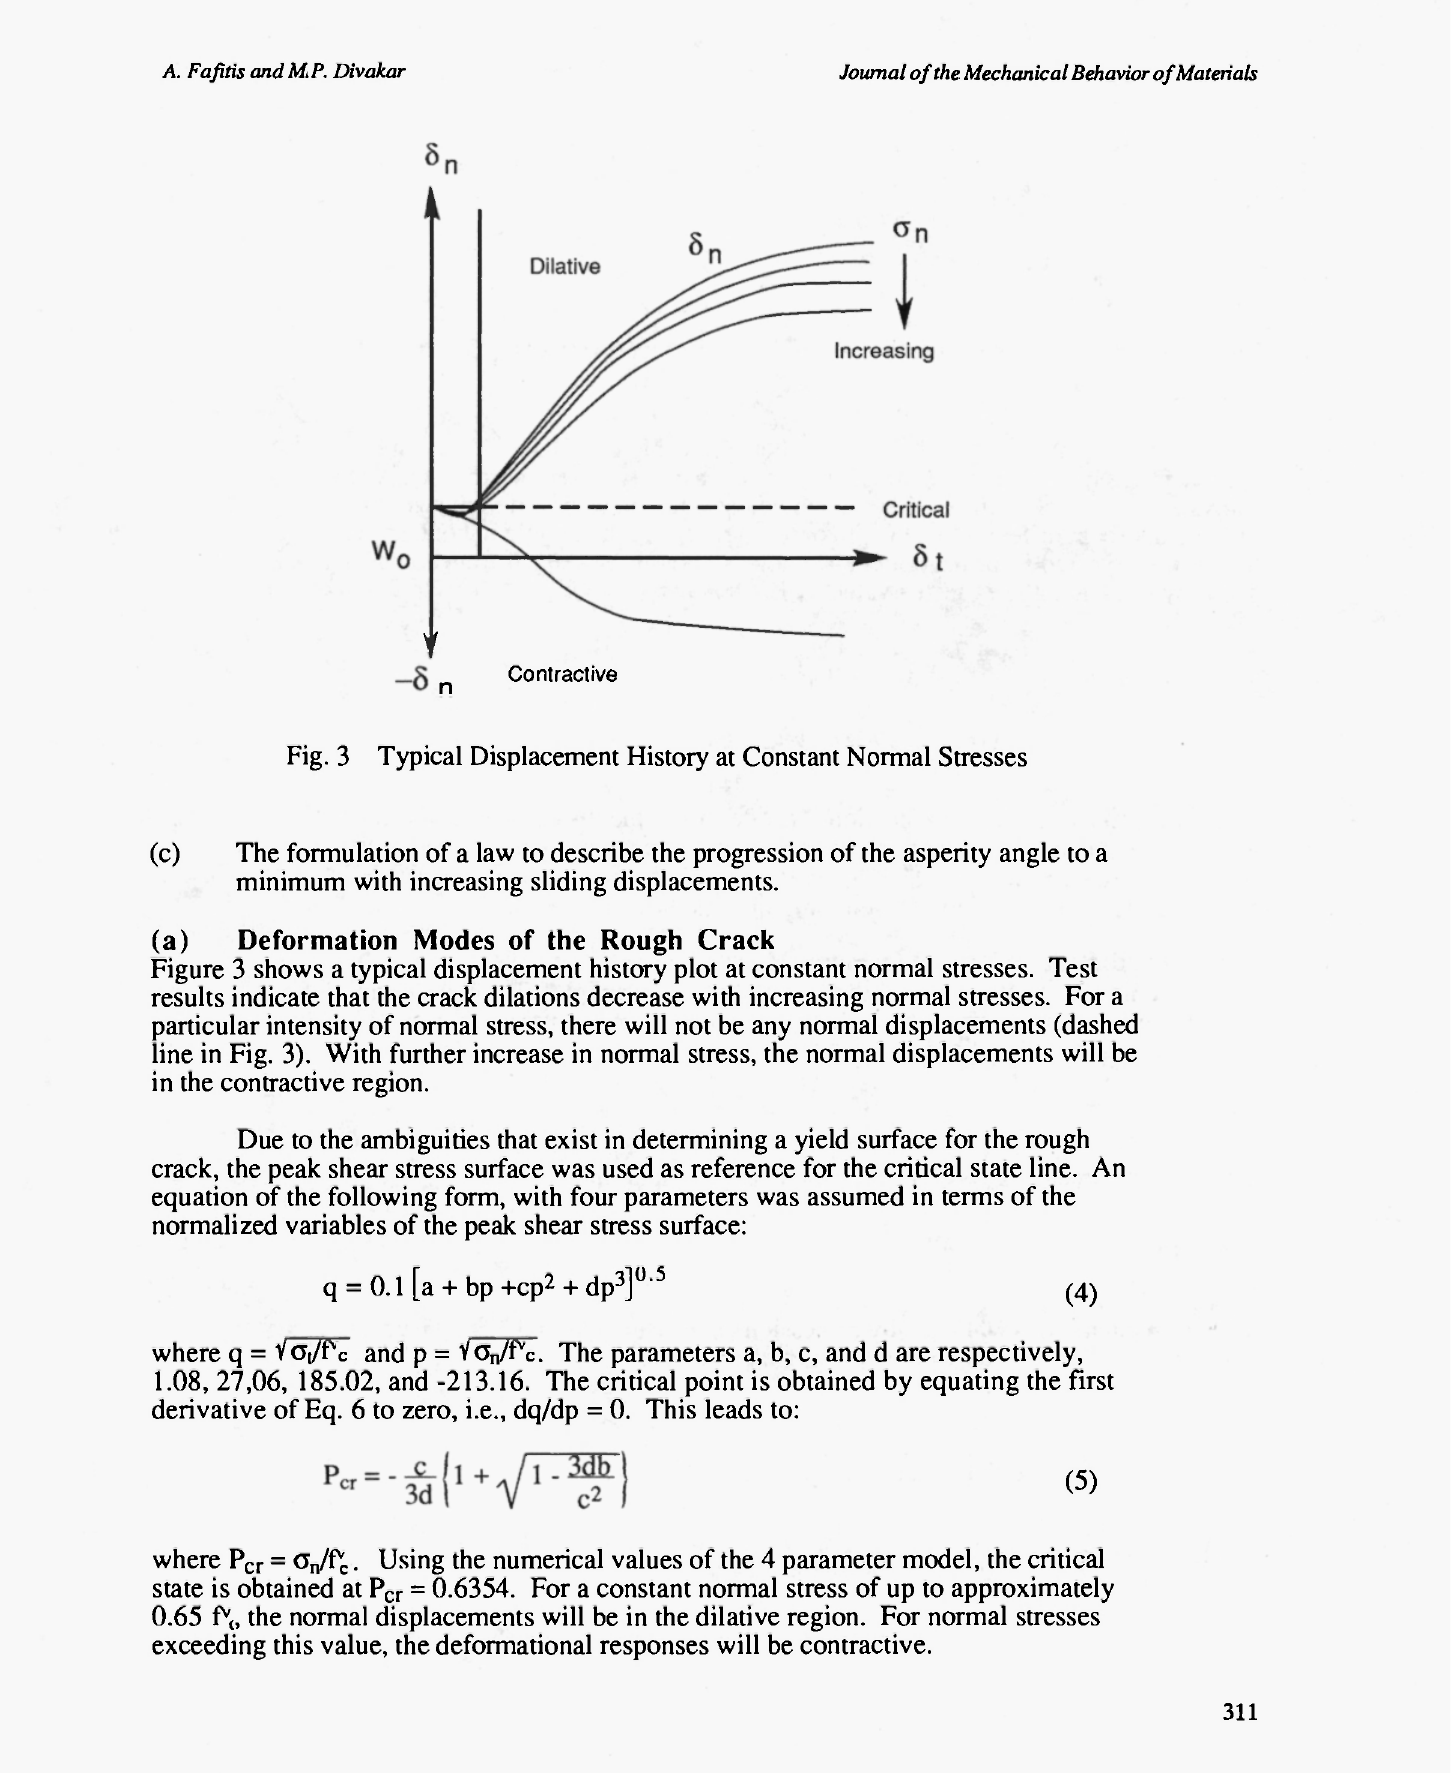
Fig. 3 Typical Displacement History at Constant Normal Stresses